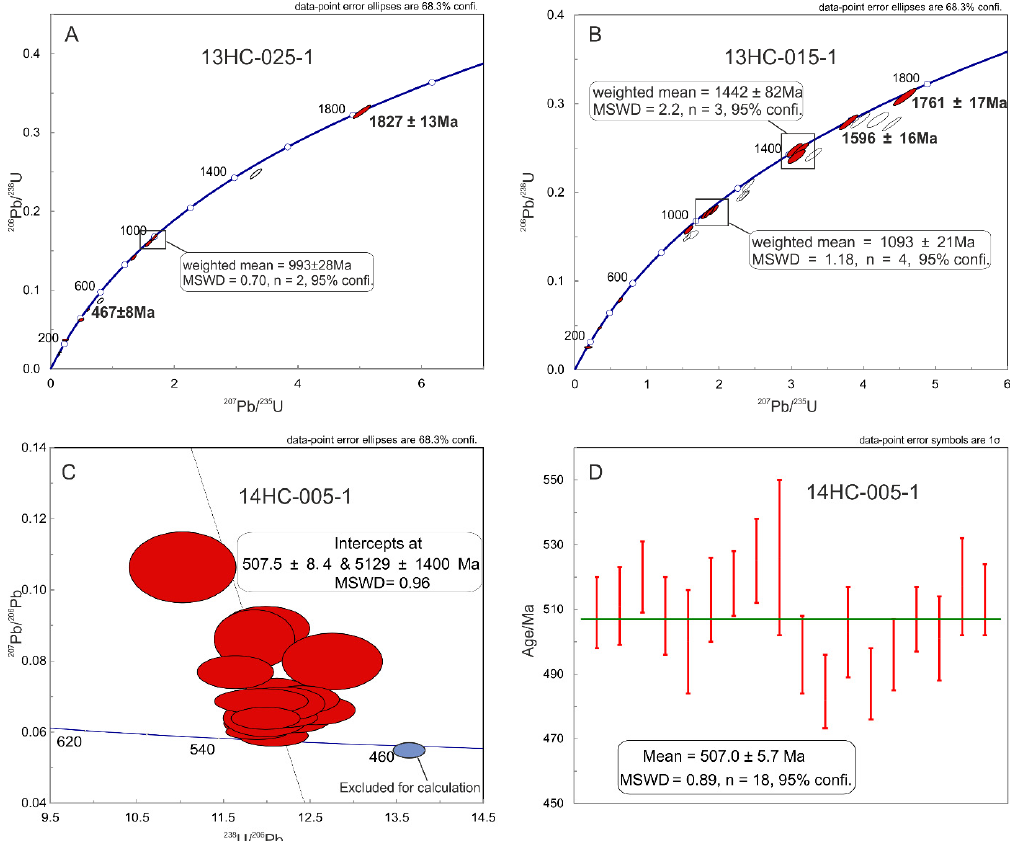
Figure 6. SHRIMP zircon U–Pb concordia plots of ( A ) Concordia plots for sample 13HC ‐ 025 ‐ 1, ( B ) Concordia plots for sample 13HC ‐ 015 ‐ 1, ( C ) Concordia plots for sample 14HC ‐ 005 ‐ 1, and ( D ) Calculation for the weighted mean age for sample 14HC ‐ 005 ‐ 1. Filled eclipses are analyses on concordia and eclipses are analyses not on concordia. Blue solid lines in ( A – C ) are concordant line and the black dashed line in ( C ) is disconcordant line.